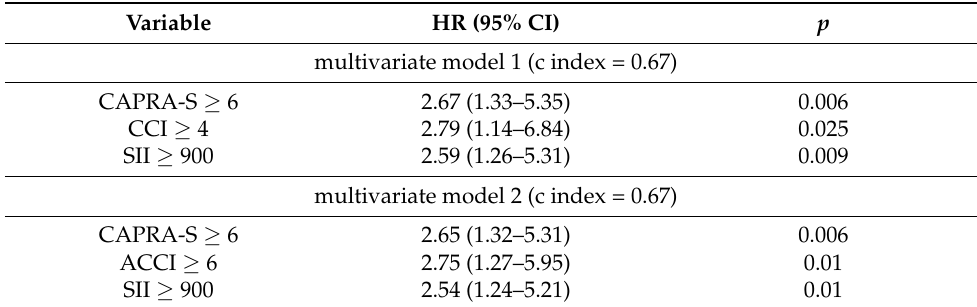
Table 3. The association of SII with overall survival in patients treated with radical prostatectomy for nonmetastatic prostate cancer-multivariable Cox regression analyses, including categorized SII, CAPRA-S and age-adjusted Charlson comorbidity index (ACCI) or age-unadjusted Charlson comorbidity index (CCI).